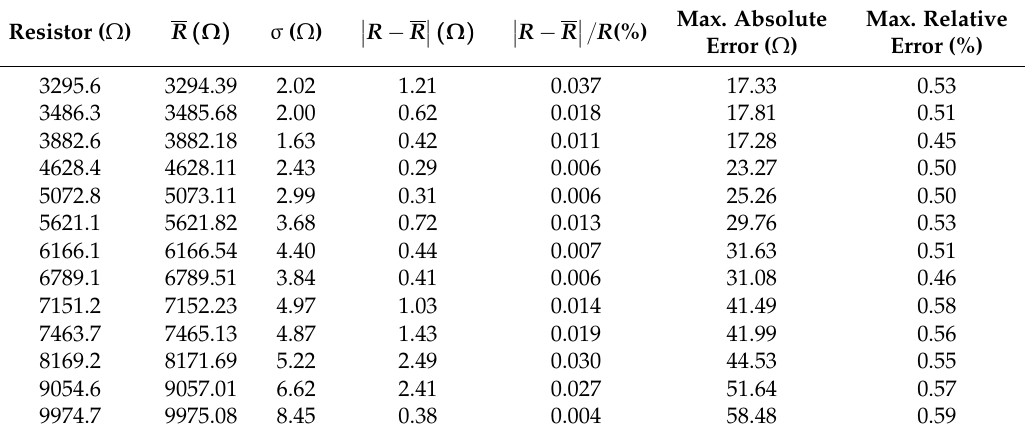
Table 2. Accuracy data for Experiment